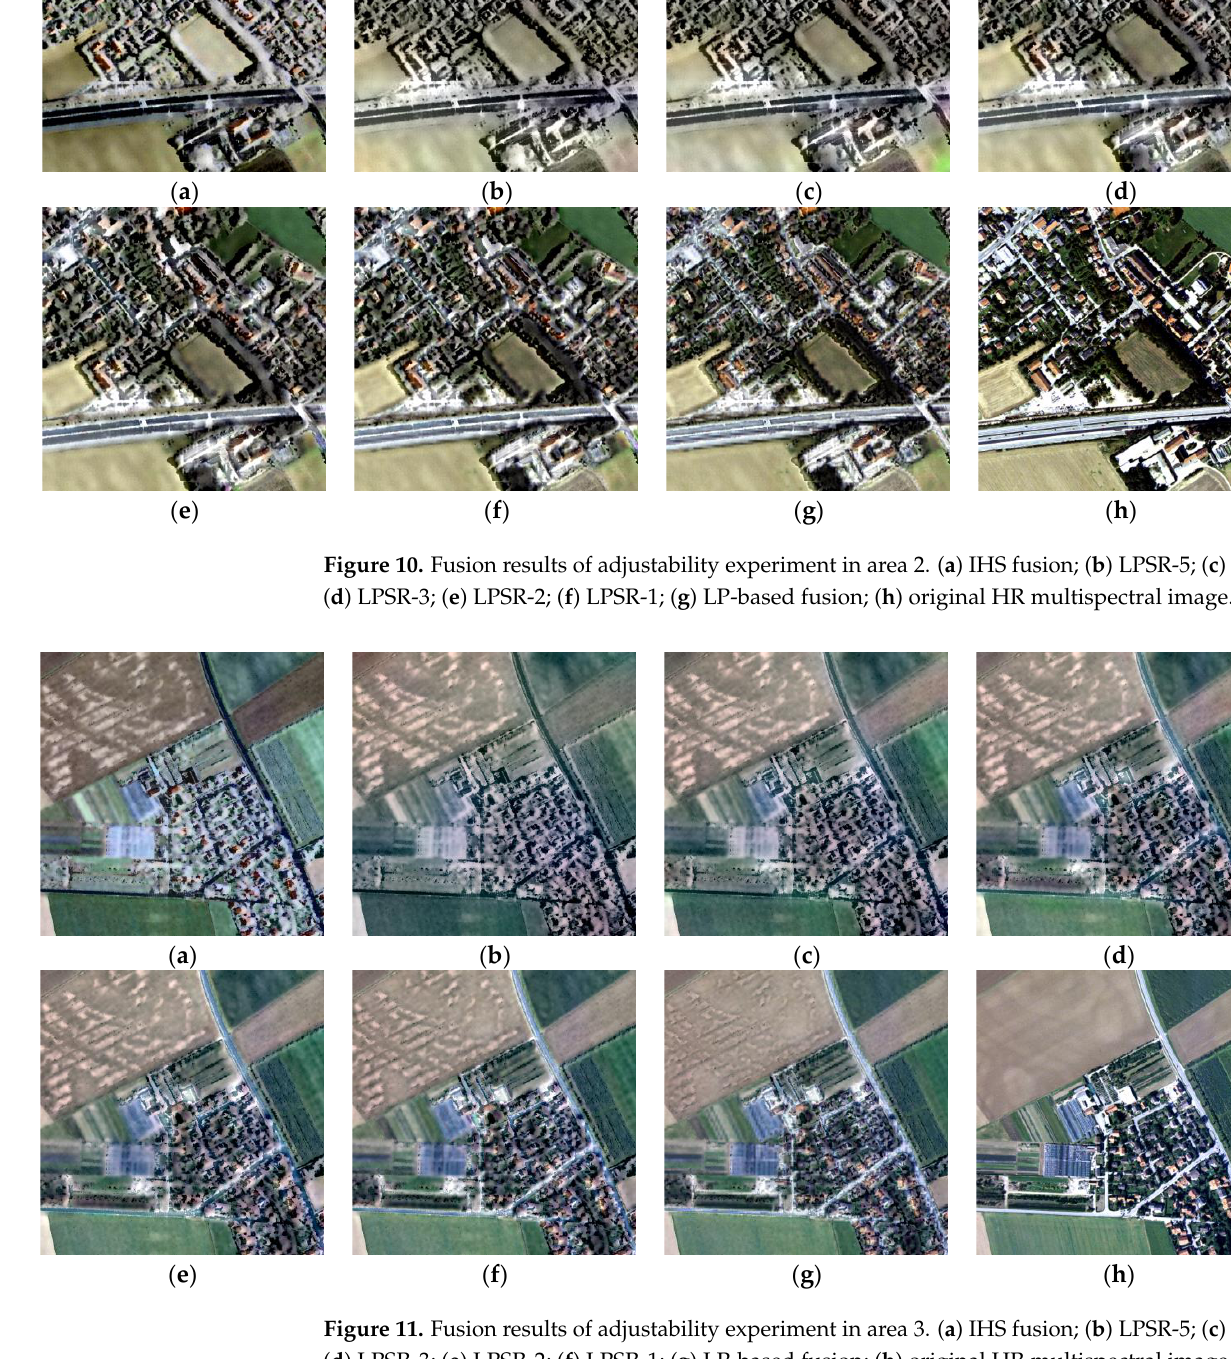
Figure 11. Fusion results of adjustability experiment in area 3. ( a ) IHS fusion; ( b ) LPSR-5; ( c ) LPSR-4; ( d ) LPSR-3; ( e ) LPSR-2; ( f ) LPSR-1; ( g ) LP-based fusion; ( h ) original HR multispectral image.